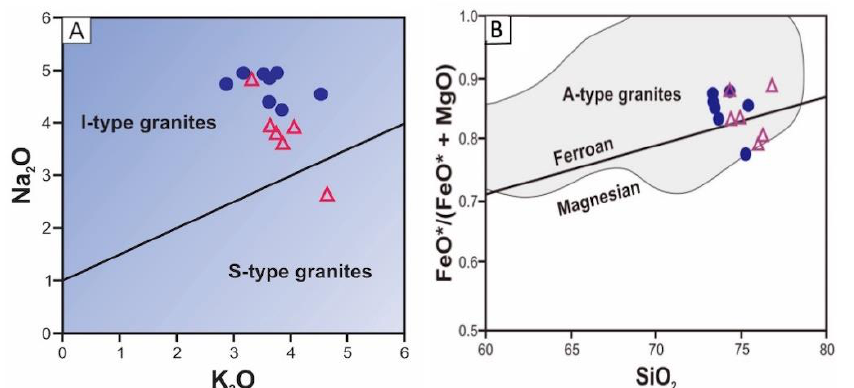
Figure 5. Discrimination diagrams of granites. ( A ) Na 2 O vs. K 2 O diagram discriminating I-type and S-type granitic rocks (after [25]). ( B ) FeO*/(FeO* + MgO) vs. SiO 2 discrimination diagram displaying the fields for ferroan and magnesian granites. A-type granites plot in the shaded area (after [26]). Symbols as in Figure 4.